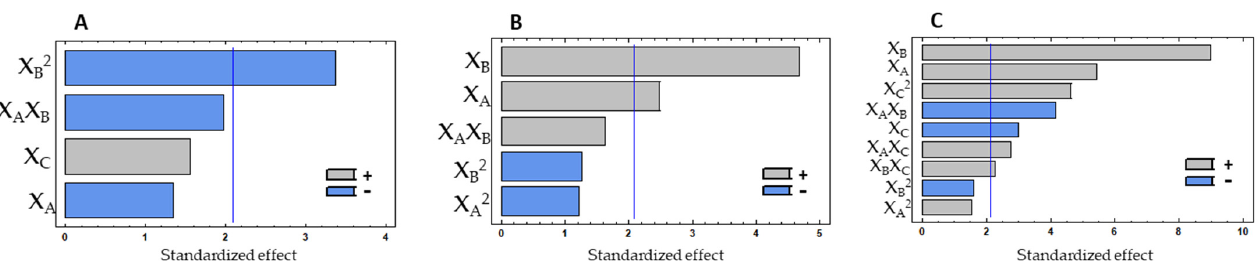
Figure 1. Pareto charts with the effect of three experimental factors, in decreasing order, obtained for protein % ( A ), antioxidant ( B ) and anti-hypertensive ( C ) properties in the experimental design with subtilisin, showing the most influent factors. The vertical lines in the pareto charts represent the level of significance ( p = 0.05). X A —Enzyme %; X B —Hydrolysis temperature; X C —Hydrolysis time.